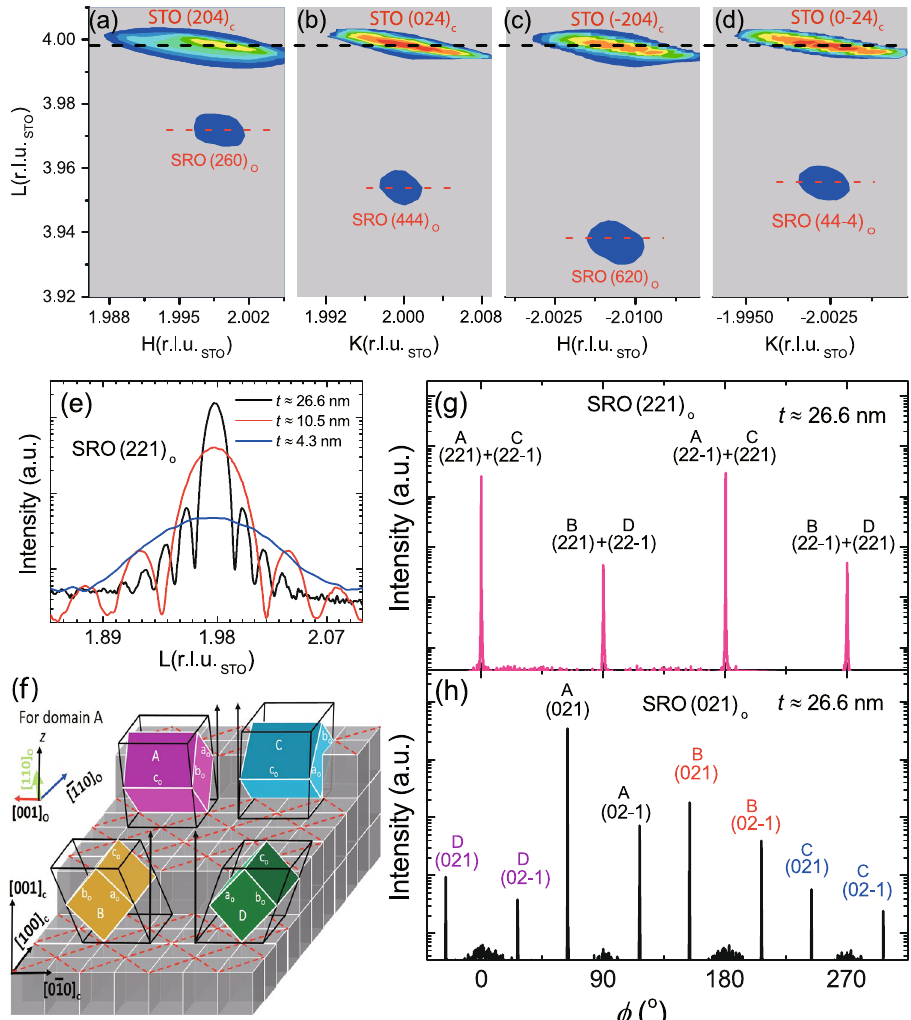
Figure 5. Structural-phase determination of the SRO( t )/STO films. ( a ) RSM for a SRO film with t ≈ 26.6 nm across ( a ) STO (204) c , ( b ) STO (024) c , ( c ) STO (−204) c , and ( d ) STO (0-24) c reflections. ( e ) The L-scans of the SRO (221) o refection for different t s. The appearance of SRO (221) o peaks infers the orthorhombic-phase down to t ≈ 4.3 nm. ( f ) An illustration of the growth orientations for the four domains A, B, C, and D. Red dashed lines show the c (2 × 2) superstructure for initial SrO layer. ( g ) and ( h ) are the φ -scans across the SRO (221) o and SRO (021) o reflections, respectively, indicating the coexistence of both 90° and 180° oriented domains in the SRO